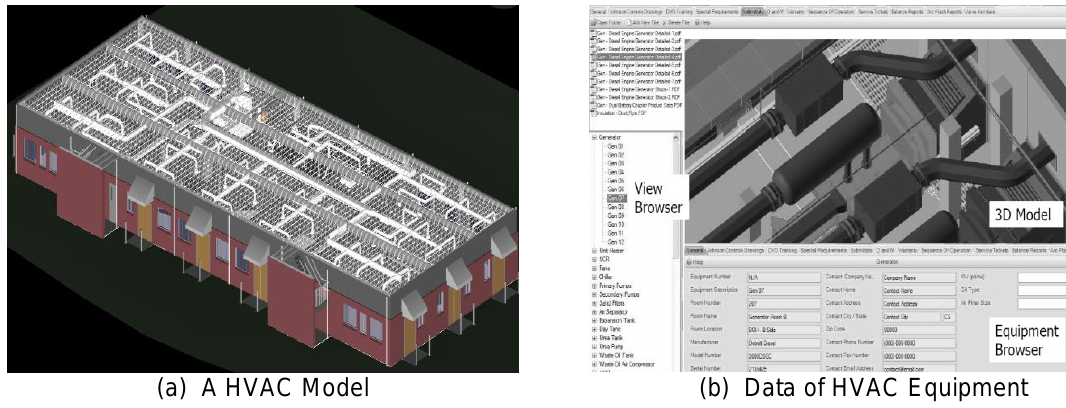
Figure 6 Illustration of use of BIM in facility